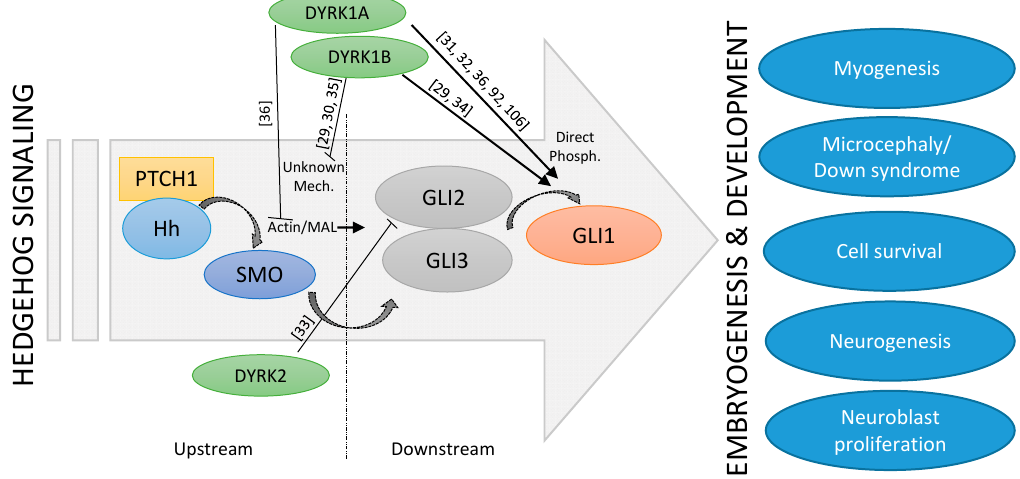
Figure 2. Schematic depiction of the cross-talk between Hh signaling and DYRK kinases. Three DYRK kinases (DYRK1A, DYRK1B, DYRK2) have been described as regulators of